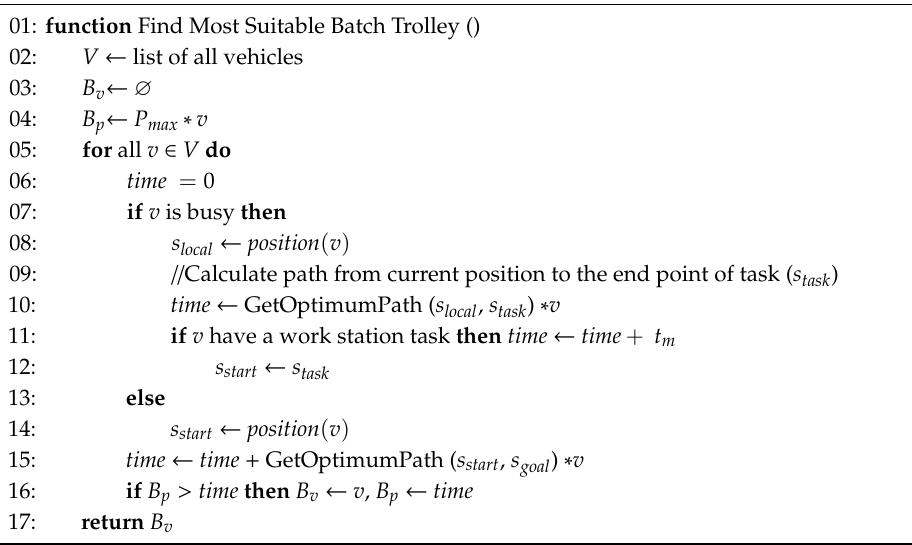
Algorithm 1 Choosing the most suitable batch